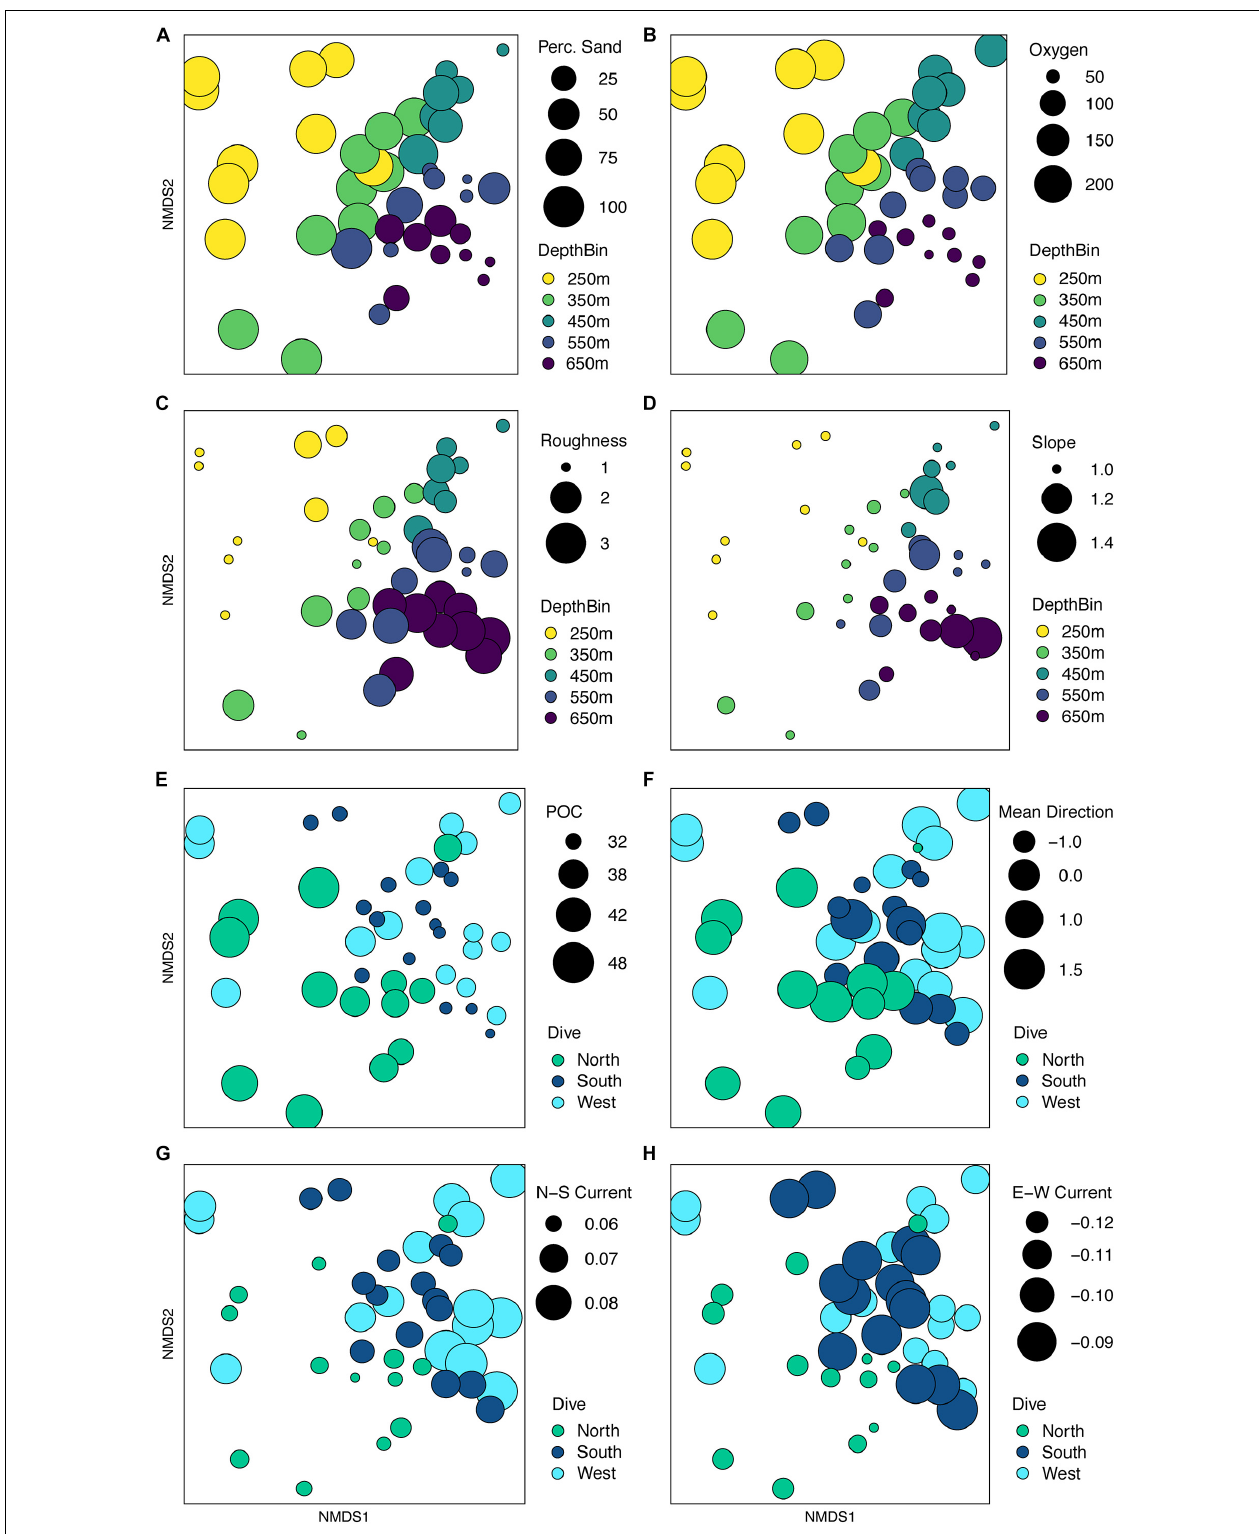
FIGURE 12 | Non-metric multidimensional scaling plot for assemblage structure of Mokumanamana from Figure 10 with overlay of environmental gradients. Circle size is relative to values of variables that change with depth or dive. Panels: (A) percent sediment, (B) oxygen ( µ M), (C) roughness, (D) standard deviation of slope, (E) mean particulate organic matter (mg/m 3 ), (F) mean direction, (G) northward current (m/s), (H) westward current (m/s).